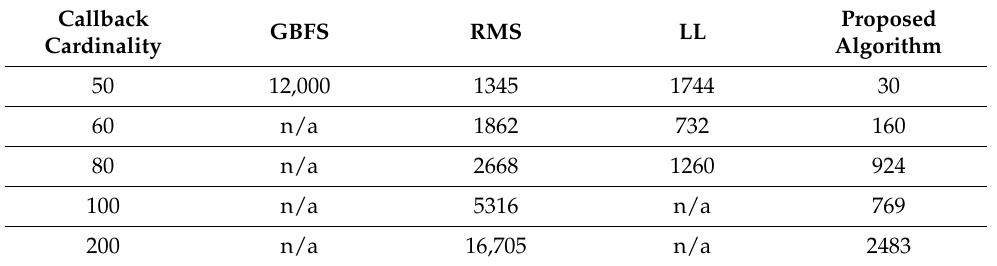
Table 4. Runtime results (in ms).